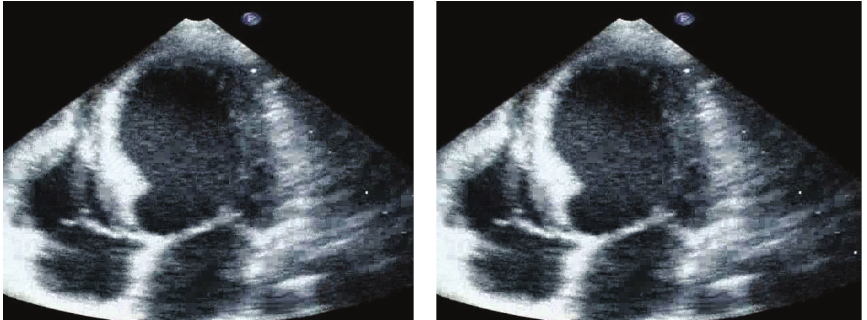
Figure 2: Transthoracic echocardiogram performed in the ED showed akinesia of left ventricular medium-distal apical septum and medium- distal anterior walls, with a 40% EF (see video).